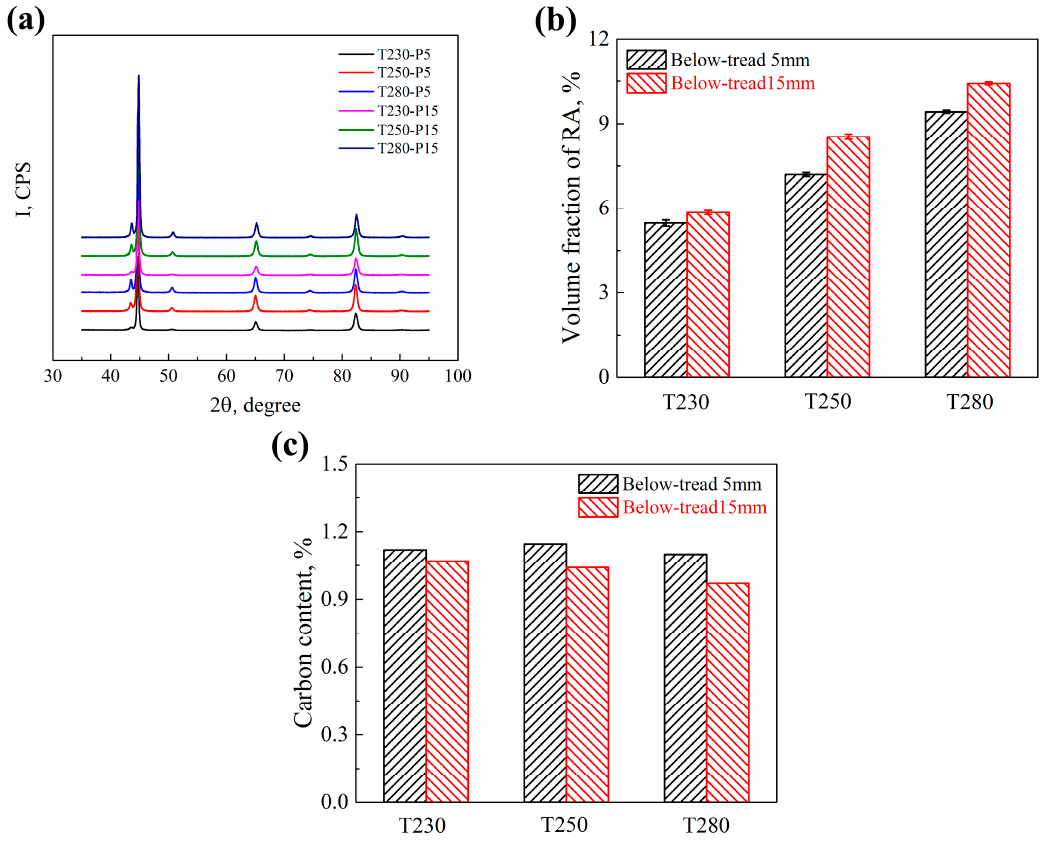
Figure 5. XRD analysis results: ( a ) XRD spectra; ( b )Volume fraction of retained austenite; ( c ) Carbon content of retained austenite.